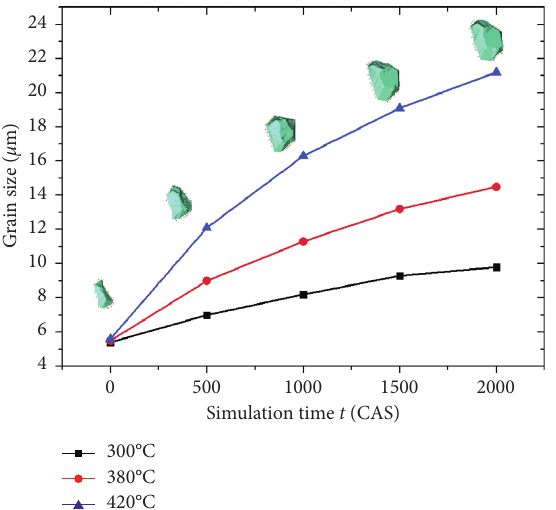
Figure 6: Grain size at different temperatures.